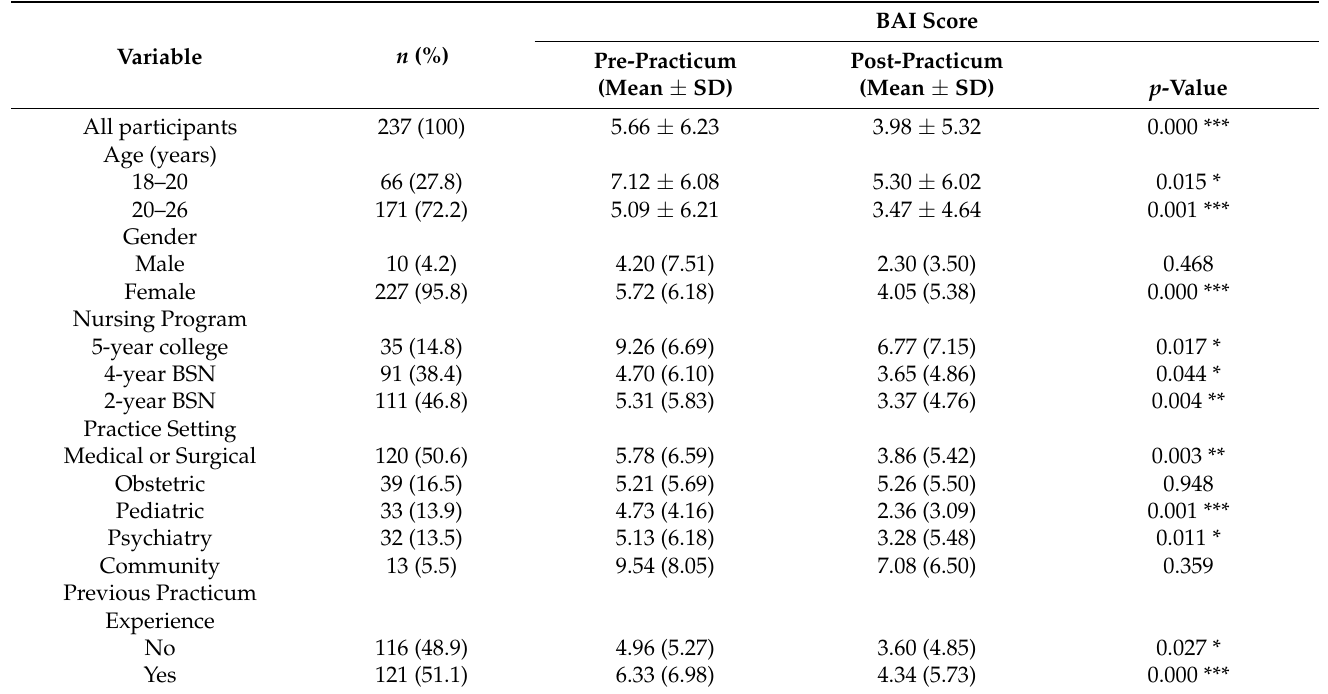
Table 1. Characteristics of the study participants and distribution of the pre-practicum and post- practicum BAI scores ( n =